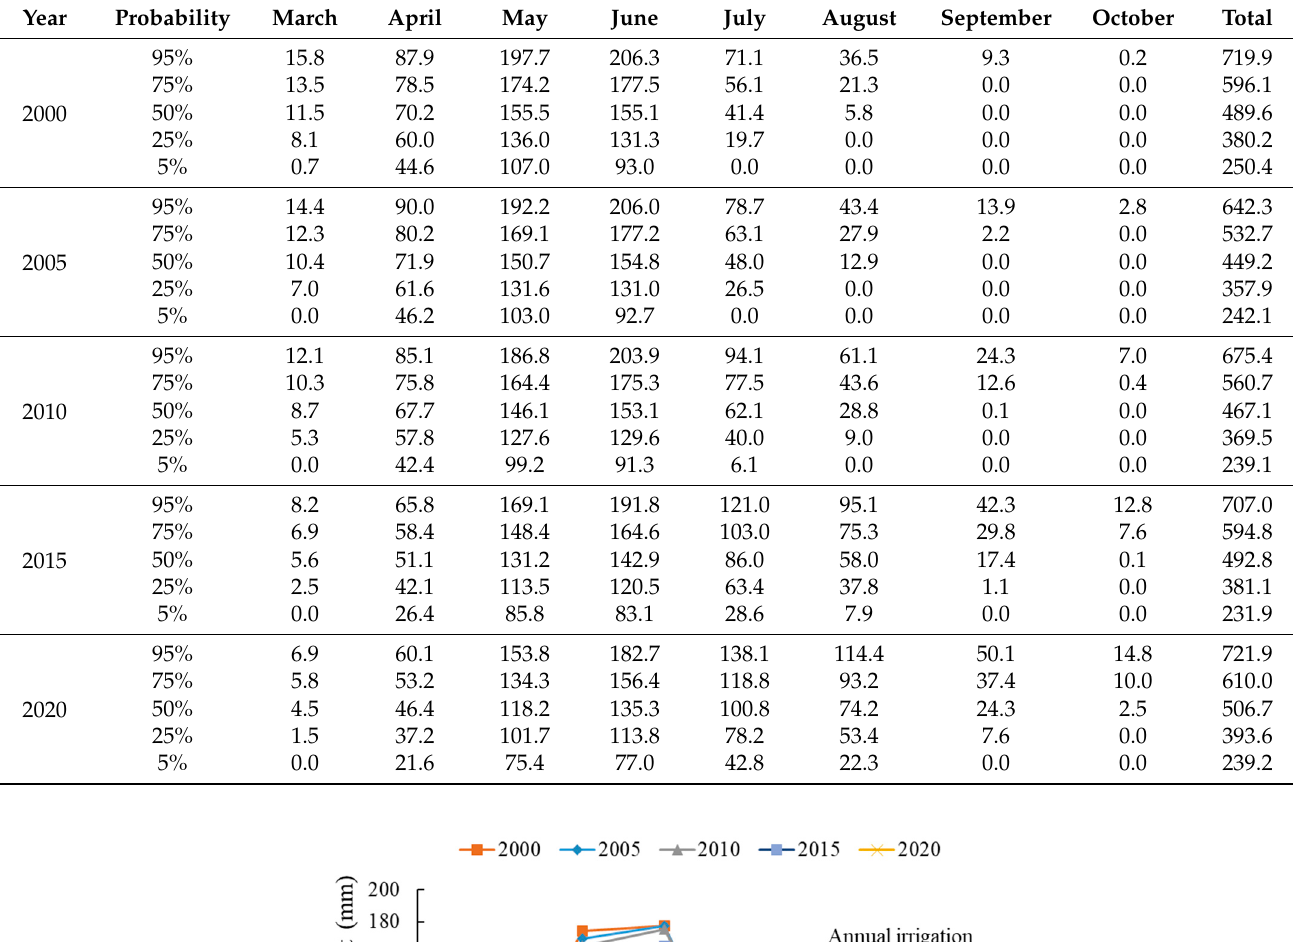
Table 5. Monthly net irrigation water requirement under different probabilities for typical years.